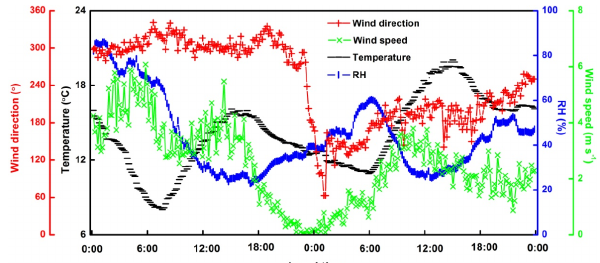
Figure 5. Temporal evolution of 10min mean meteorological pa- rameters during the new particle formation event on 3 and 4 April 2012.